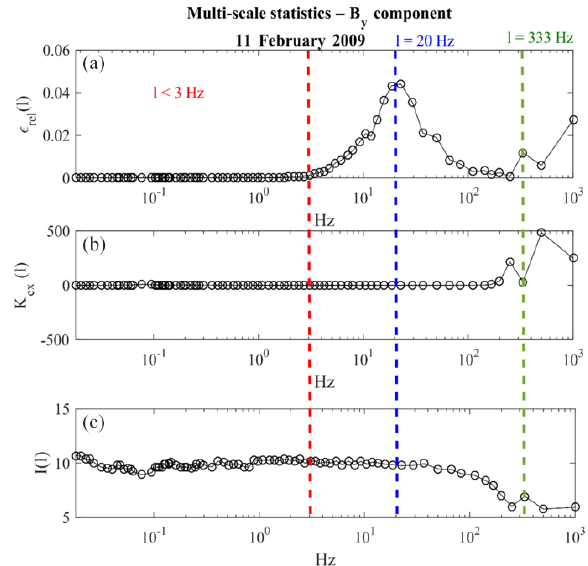
Figure 3. Example of a multiscale statistical analysis of the B y component for the same data of Fig. 2: (a) (cid:15) rel vs. frequency; panel (b) K ex vs. frequency; panel (c) I vs. frequency. Two energy peaks, at 20Hz and at 333Hz are clearly